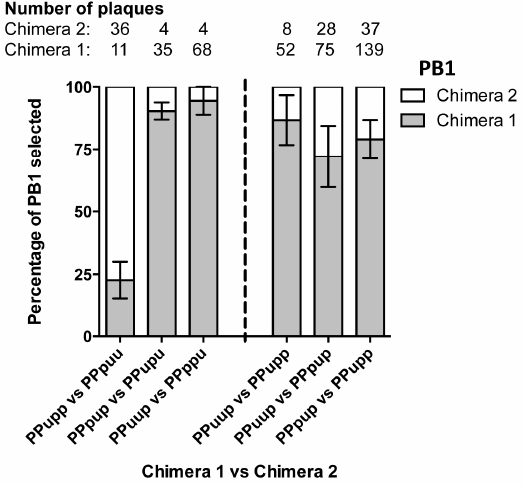
Figure 7. Frequency of competing chimeric genes incorporated in progeny viruses resulting from nine ‐ plasmid competitive transfection assays. Nine ‐ plasmid competitive transfections were